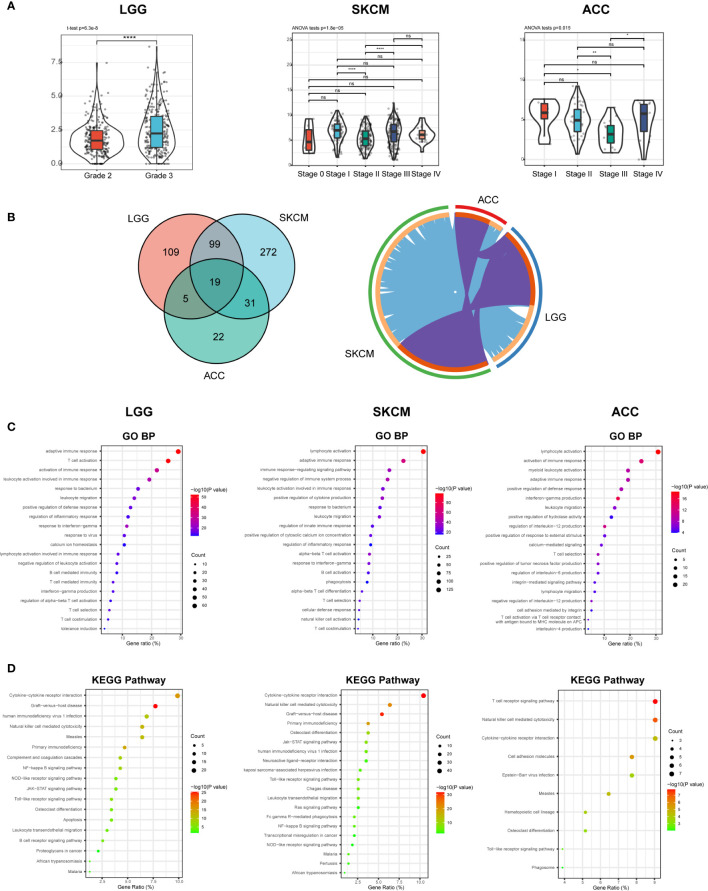
CD96 expression and function profiles in three representative cancers. (A) CD96 expression levels in different grades or stages in LGG, SKCM, and ACC, respectively (*P < 0.05, **P < 0.01, ***P < 0.001). (B) 232, 421, and 77 related genes were identified in LGG, SKCM, and ACC cohorts. Circos plot showed overlaps in genes (purple curves) and enriched ontology terms (blue curves) between three lists based on their functions or shared pathways. (C, D) GO and KEGG analysis of CD96-related signatures in LGG, SKCM, and ACC.